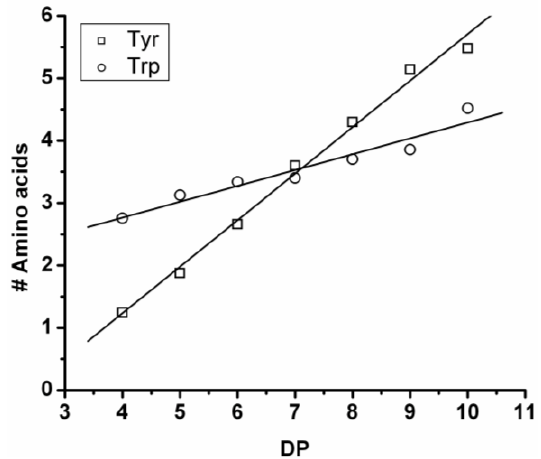
Figure 9. Average number of amino acids in poly(Tyr-co-Trp) for every observed